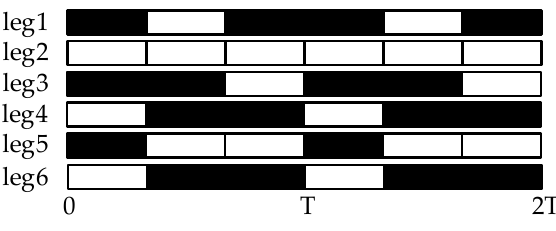
Figure 7. Phase sequence table of fault tolerant tripod gait in leg 2 fault state.